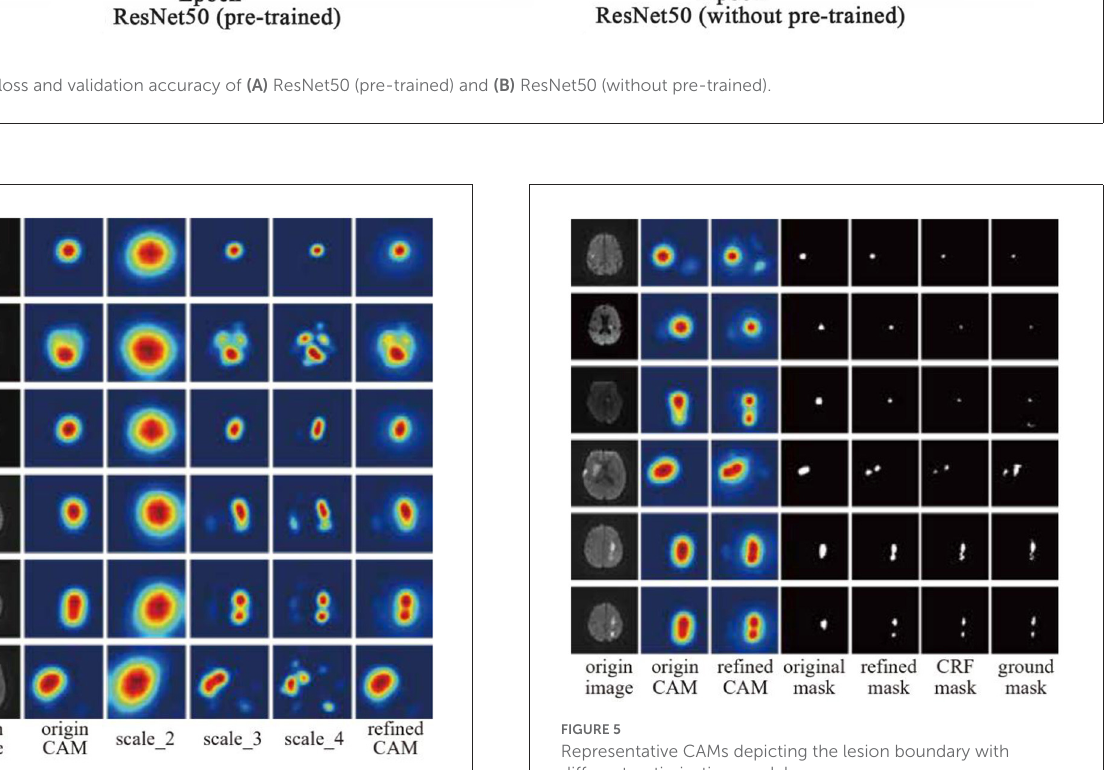
FIGURE4 Visualization of multi-scale CAMs inference.